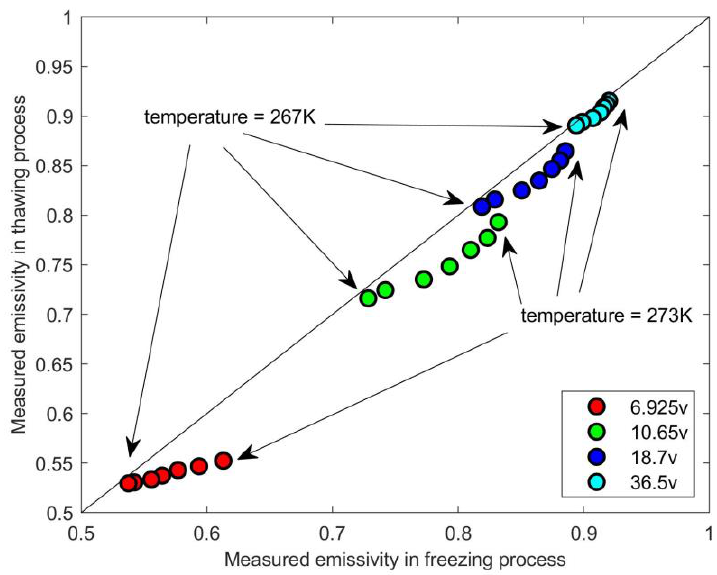
Figure 9. The measured emissivity at di ff erent frequencies during freezing and thawing process.